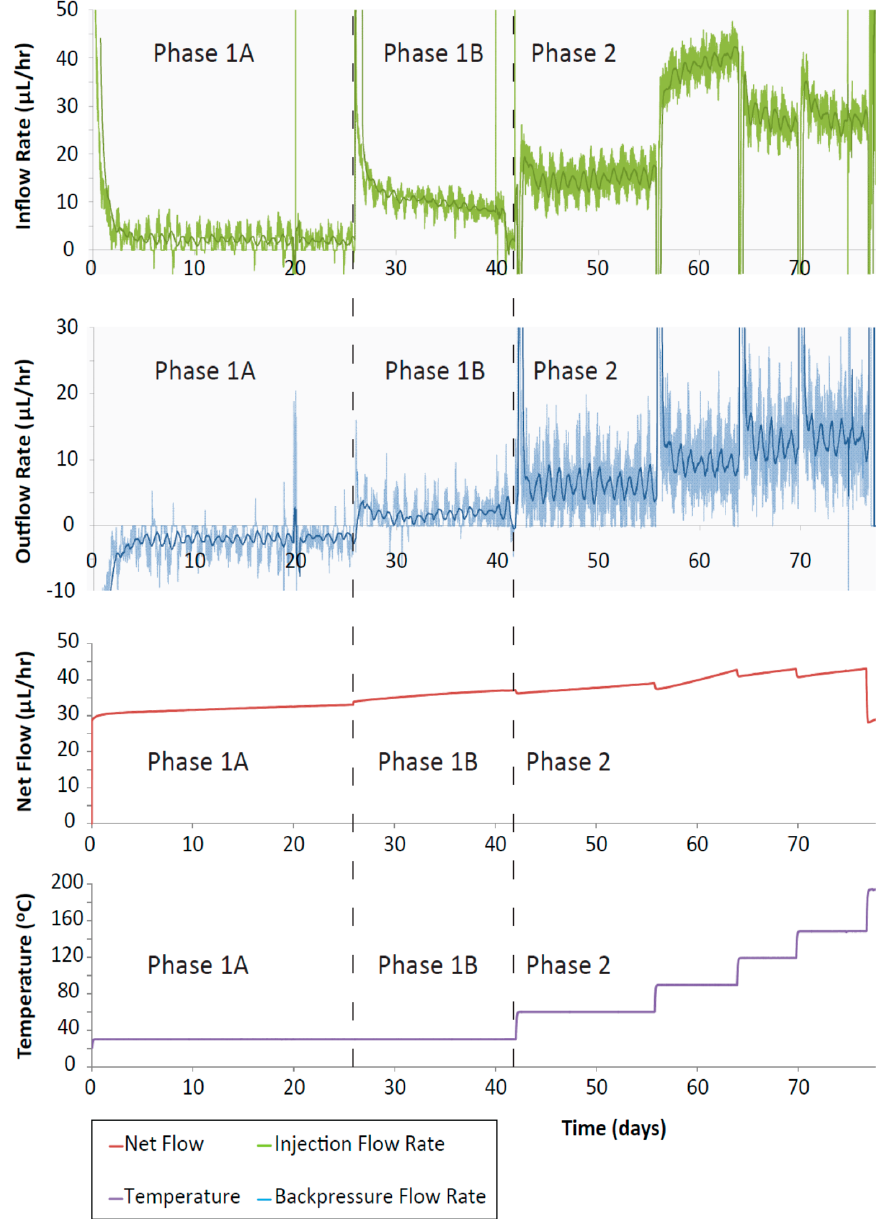
Figure 8. CVRF-2 test inflow and outflow rates and net flow against time. There is a small increase in inflow with increasing temperature increments up to 119 °C after which it decreases. Outflow rate during the initial hydration (phase 1A) is negative because the clay is absorbing fluid from the pump. Positive outflow rates represent fluid migrating into the pump from the apparatus.